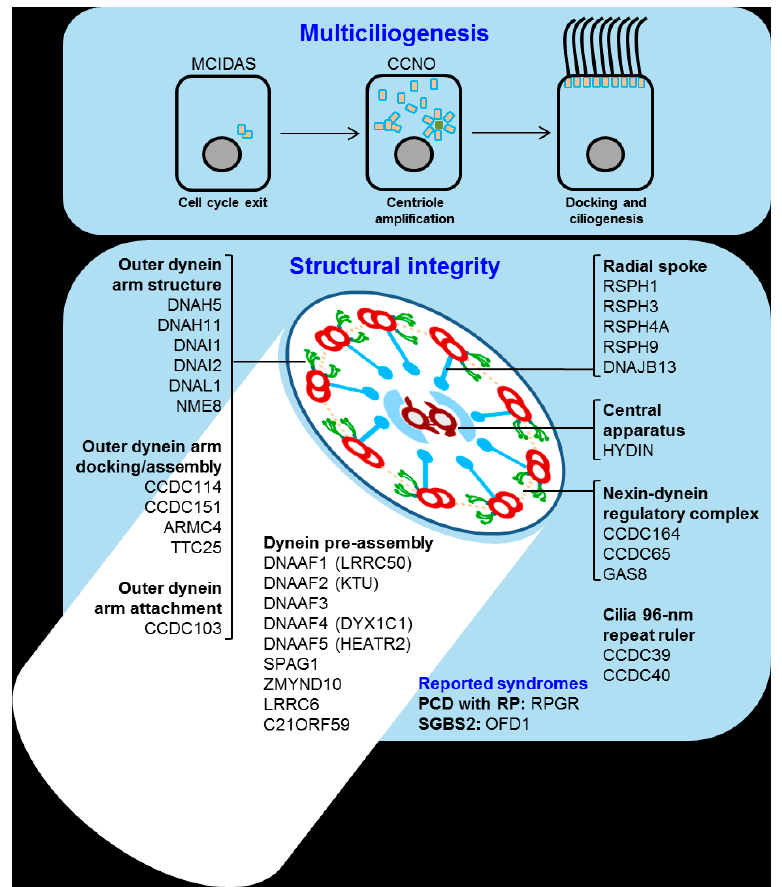
Figure 5. Structure of motile cilia and role of mutant proteins. Motile ciliopathies are caused by mutations in the (top panel) components of the ciliogenesis pathway or (bottom panel) structural and attachment proteins of the axoneme dynein ‘arm’ motors (green), the dynein arm docking complex, the nexin–dynein regulatory complex (dotted lines), the central apparatus (brown), the radial spokes (blue), as well as molecular ruler proteins and cytoplasmic dynein arm assembly factors. Reported syndromes are: primary ciliary dyskinesia (PCD) associated with retinitis pigmentosa (RP), and Simpson–Golabi–Behmel syndrome, type 2 (SGBS2). Reproduced with permission from